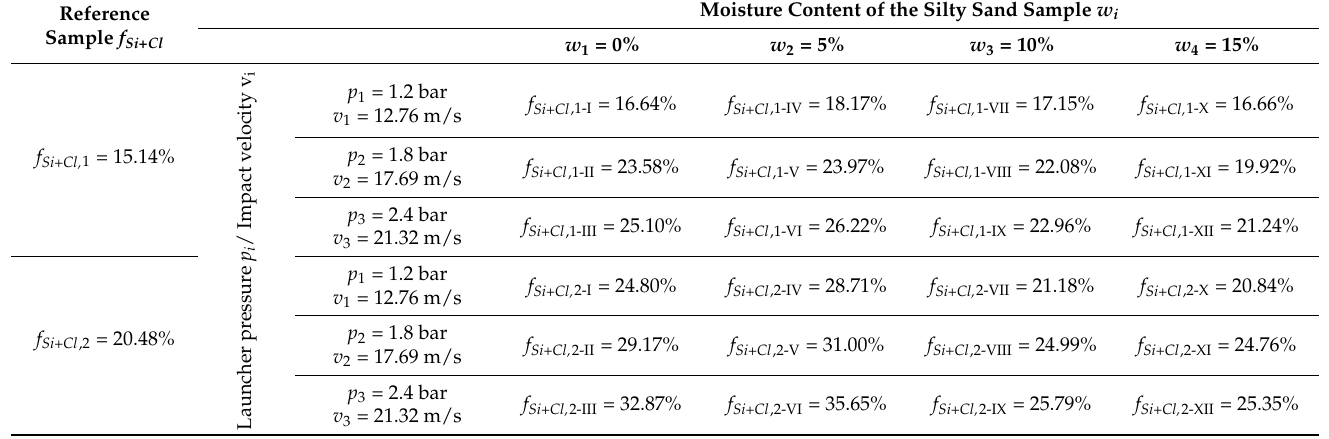
Table 5. Summary of f Si+Cl silty and clay fraction values obtained in the laser particle size analyzer for the different configurations of the variable variants of the silty sand sample after dynamic impact in the SHPB test.